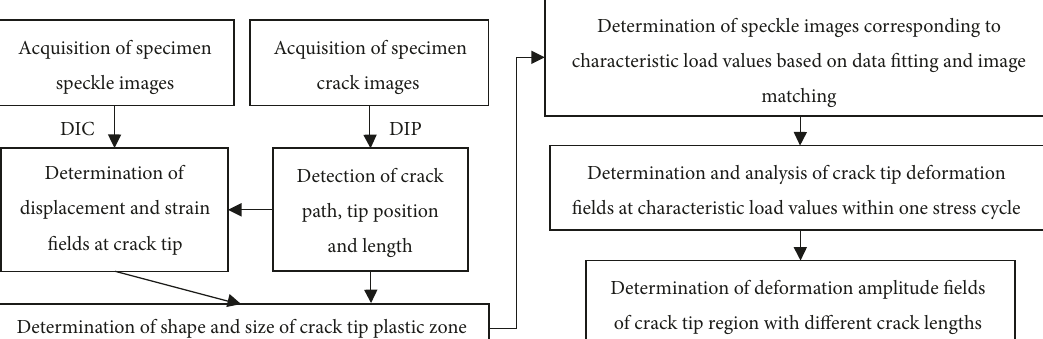
Figure 1: The block diagram of the proposed measuring method.